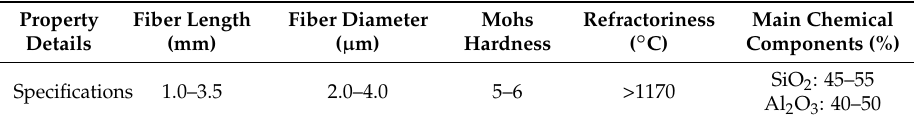
Table 2. Details of the ceramic fibers used in brake composites.